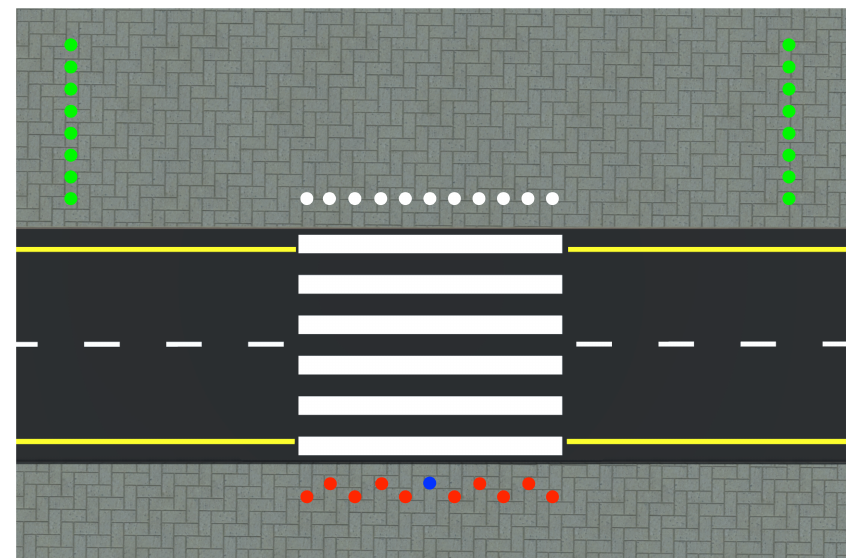
Figure 2. The positions the virtual pedestrians were initialized on the sidewalk are indicated by red circles, and they were scripted to reach one of the target positions indicated by white circles. Then the virtual pedestrians were asked to reach one the of green circles to alleviate congestion on the sidewalk. The participants were placed on the blue circle. All circles were not visible during the study. The blue circle corresponded to a marked location in the motion capture